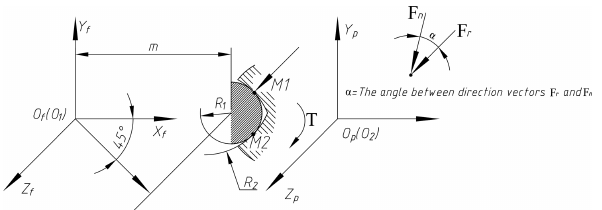
Figure 2. Schematic illustration of the tooth profile section and force